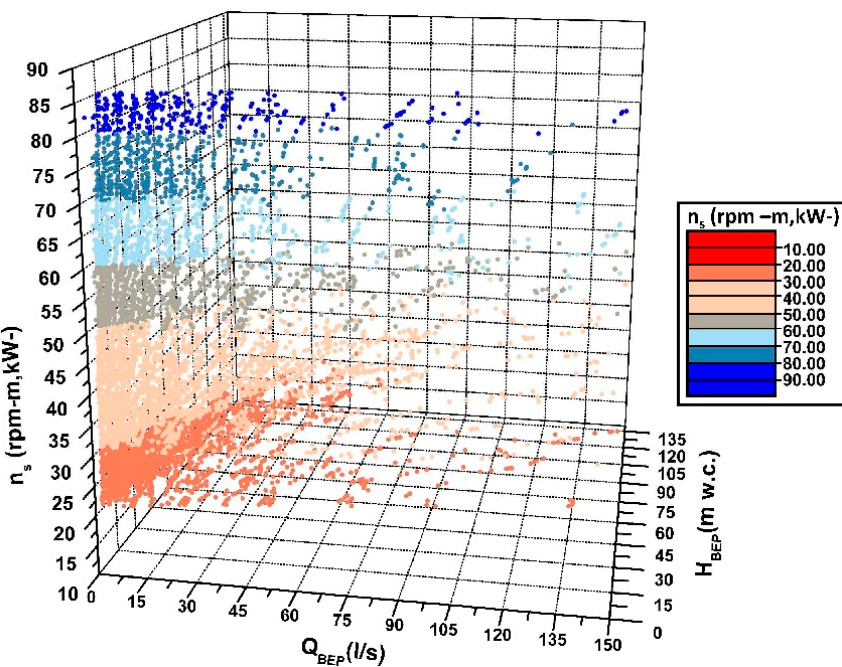
Figure 7. Database of turbines created by the turbine module based on the experiments and affinity laws.